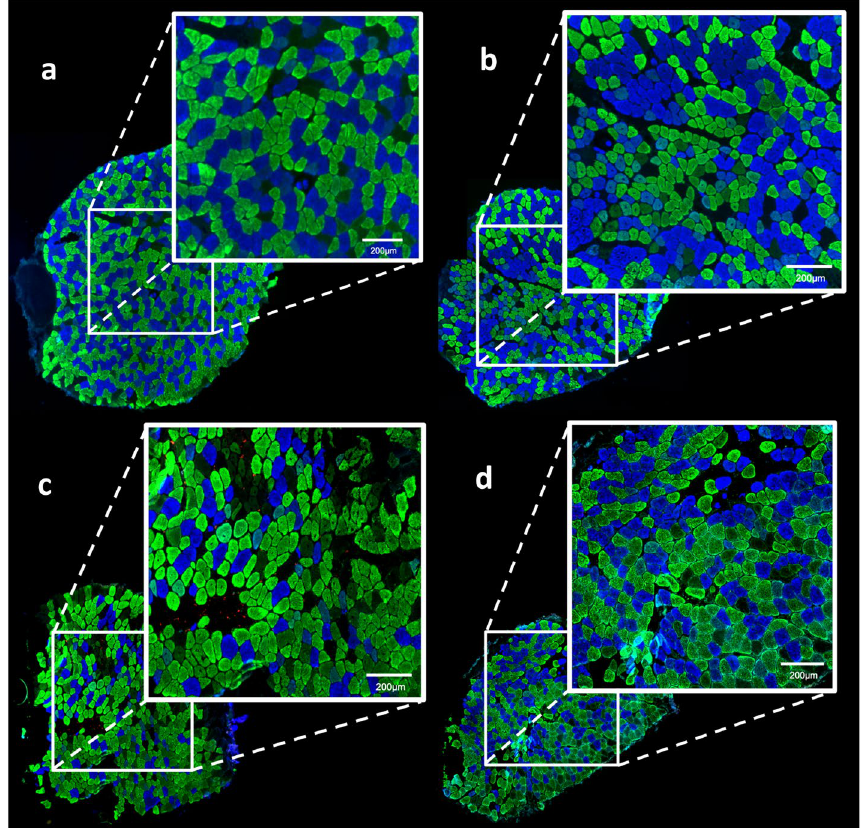
Figure 3. Photomicrographs of soleus muscle immunolabelled by different myosin heavy chain (MHC) antibodies. MHCI (FTI) stained in blue; MHCIIA (FTIIA) stained in green; MHCIID (FTIID) did not stain (black color) and MHCIIB (FTIIB) stained in red. There are not FTIIB in soleus muscle. A wt SED sample, showing a homogeneous distribution between FTI (blue color) and FTIIA (green color); B mdx SED sample, showing a grouping of fibers; C mdx TR 3 sample, showing heterogeneity in fiber distribution with an increase of FTIIA (green fibers) and FTIID (black fibers) and a decrease of FTI (blue fibers). D mdx TR 21 sample, showing a larger degree of homogeneity between FTI (blue fibers) and FTIIA (green fibers). Bars: 200 μm. Abbreviations: wild-type Sedentary group ( wt SED); mdx Sedentary group ( mdx SED); wild-type Training group for 3 days ( wt TR 3 ); mdx Training group for 3 days ( mdx TR 3 ); wild-type Training group for 21 days ( wt TR 21 ); and mdx Training group for 21 days ( mdx TR 21